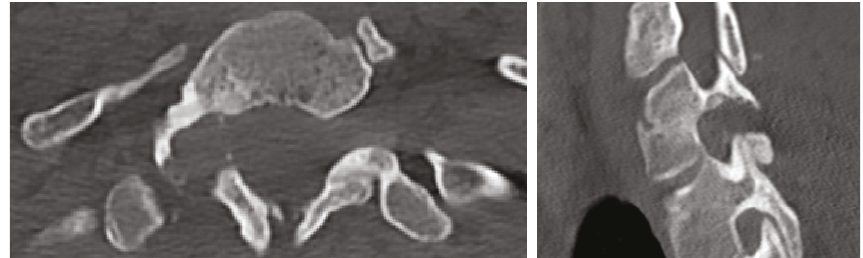
Figure 4: Postoperative spine CT scan after one week. The images con fi rmed the complete resection of the lesion, without destabilizing the vertebral column.